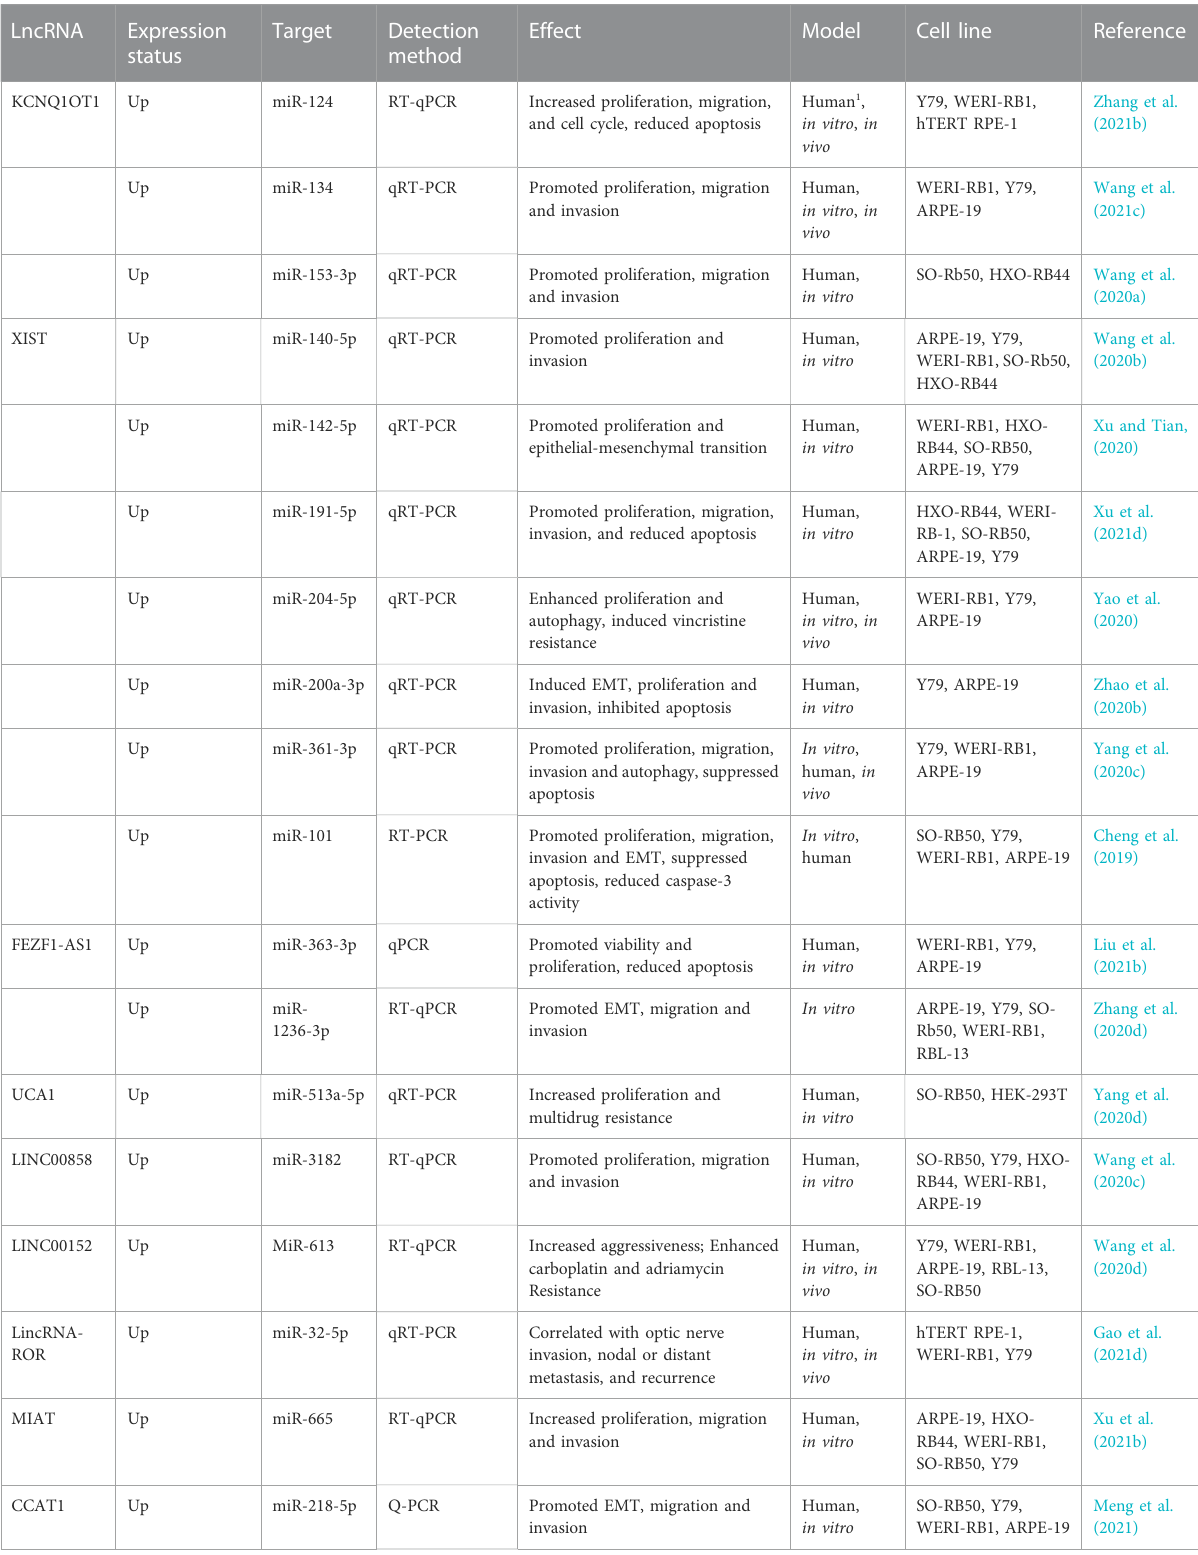
TABLE 2 The role of lncRNAs in